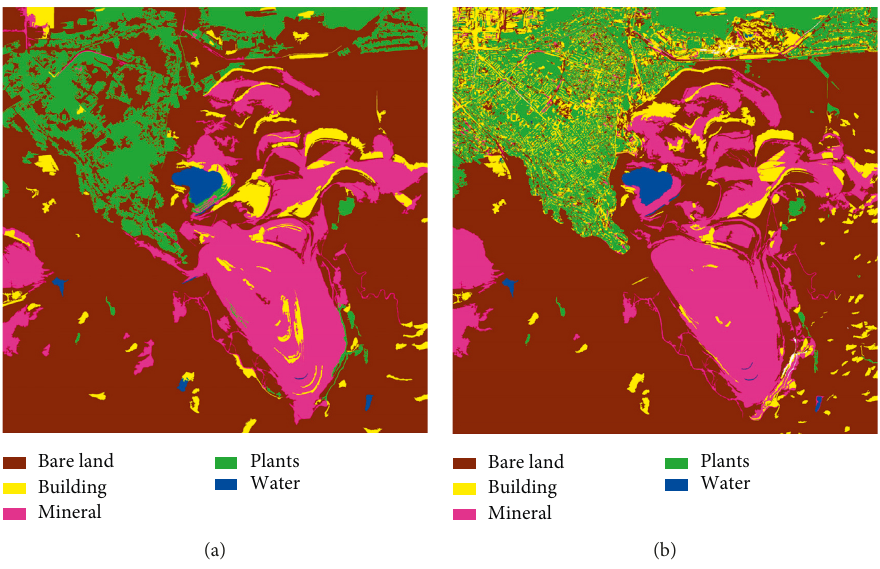
Figure 8: Classification of image B. (a) Overall classification. (b) Scene